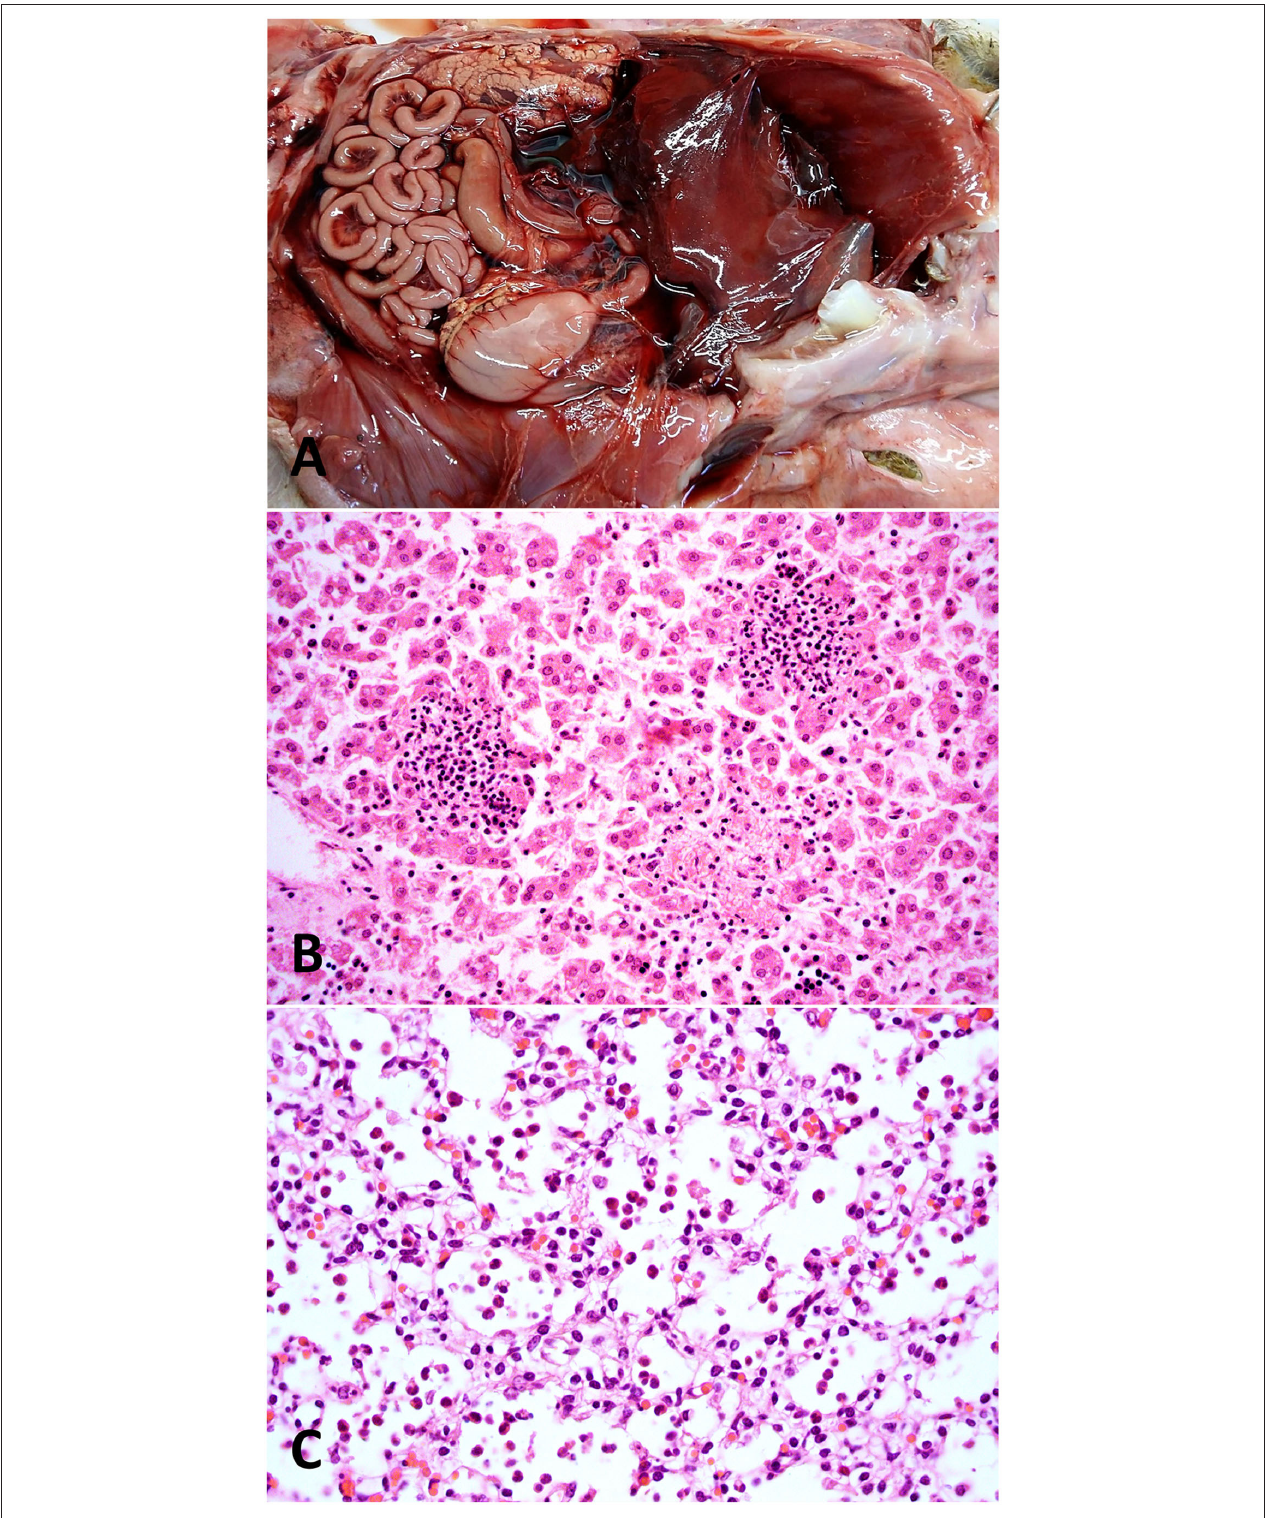
FIGURE 4 | Pathological findings in a fetus with an etiologic diagnosis of campylobacteriosis. (A) Abdominal cavity, fibrinous peritonitis and hepatic capsulitis with fibrinous adhesions between the hepatic capsule and the diaphragm. (B) Liver, multifocal random necrotizing and neutrophilic hepatitis. Hematoxylin and eosin stain, original magnification 400 × . (C) Lung, alveolar spaces contain moderate numbers of neutrophils (neutrophilic alveolitis/pneumonia). Hematoxylin and eosin stain, original magnification 400 × .